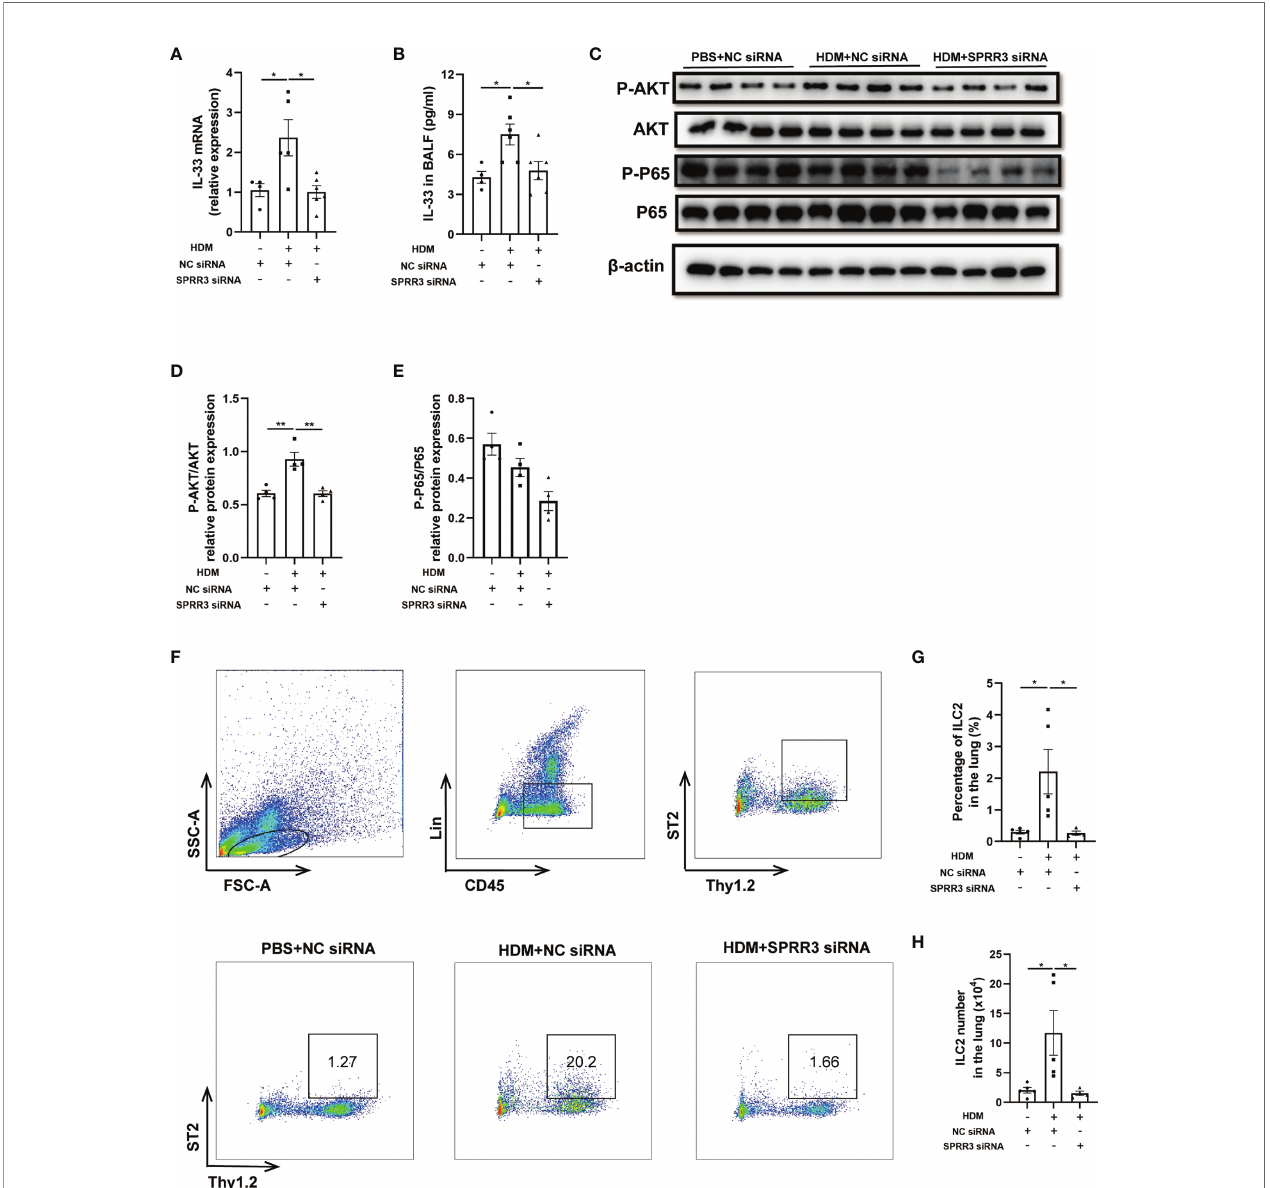
FIGURE 4 | SPRR3 knockdown inhibits the expression of IL-33 and ILC2 accumulation in mice. (A) The mRNA expression of IL-33 measured using quantitative PCR. (B) The protein levels of IL-33 in bronchoalveolar lavage fl uid (BALF) determined by ELISA. (C) Western blotting analysis of AKT and NF- k B signaling pathway activation. (D) Quanti fi cation of phosphorylation AKT normalized to total AKT, shown as relative expression. (E) Quanti fi cation of phosphorylation NF- k B P65 normalized to total NF- k B P65, shown as relative expression. (F) Flow cytometric dot plots of ST2 + Thy1.2 + ILC2s gated on CD45 + LIN − cells. (G) Percentage of ILC2 in the lung. (H) ILC2 numbers in the lung. Values represent mean ± SEM, n = 4 – 6 for each group. * p < 0.05, ** p <